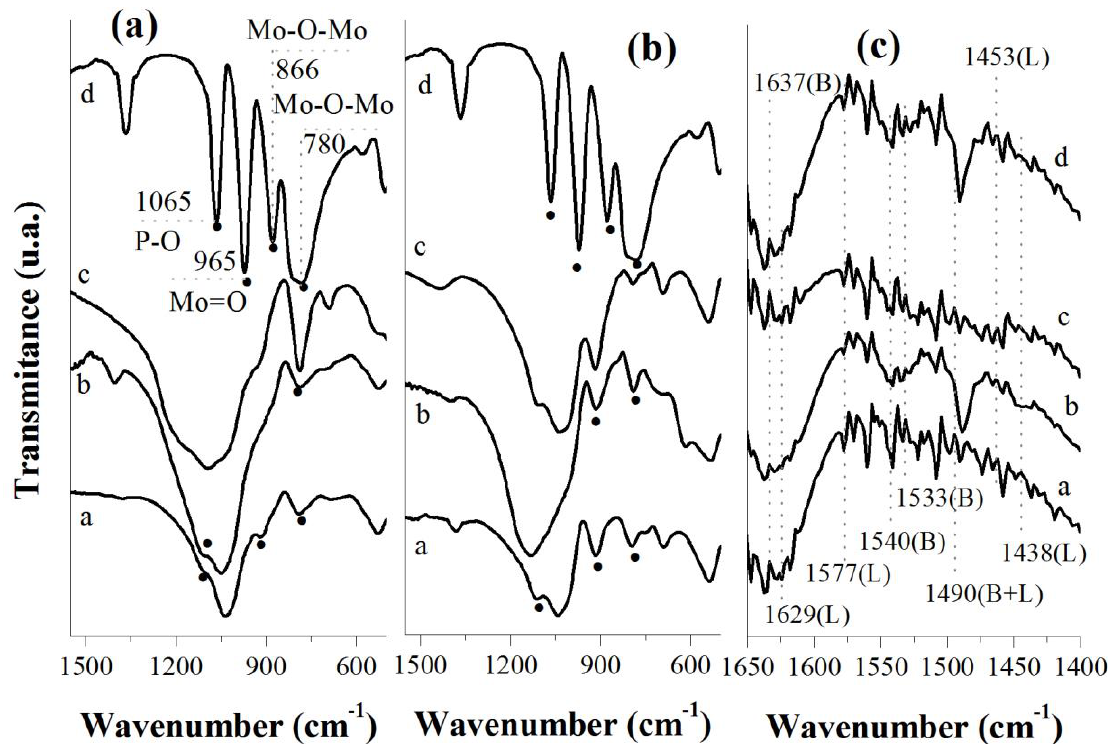
Figure 5. Fourier transform infrared spectroscopy (FTIR) spectra for samples: ( a ) a—BLM, b—BLMW, c—BL, d—HPMo; ( b ) a—BCM, b—BCMW, c—BC, d—HPMo; ( c ) samples treated with pyridine, a—BL, b—BLMW, c—BC, d—BCMW.